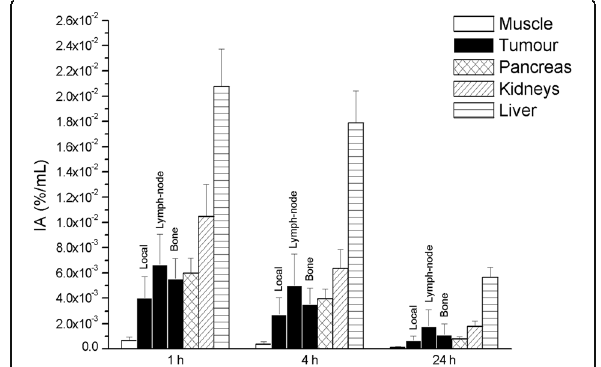
Fig. 4 Specific concentration (as a percentage of injected activity) for lesions (for each site of disease) and the main organs at risk 1, 4 and 24 h after